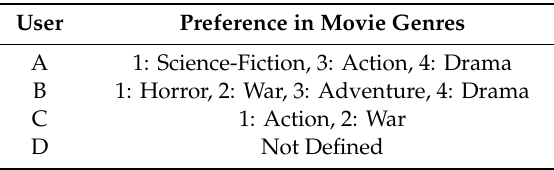
Table 10. User preferences in movie genres extracted from user personal